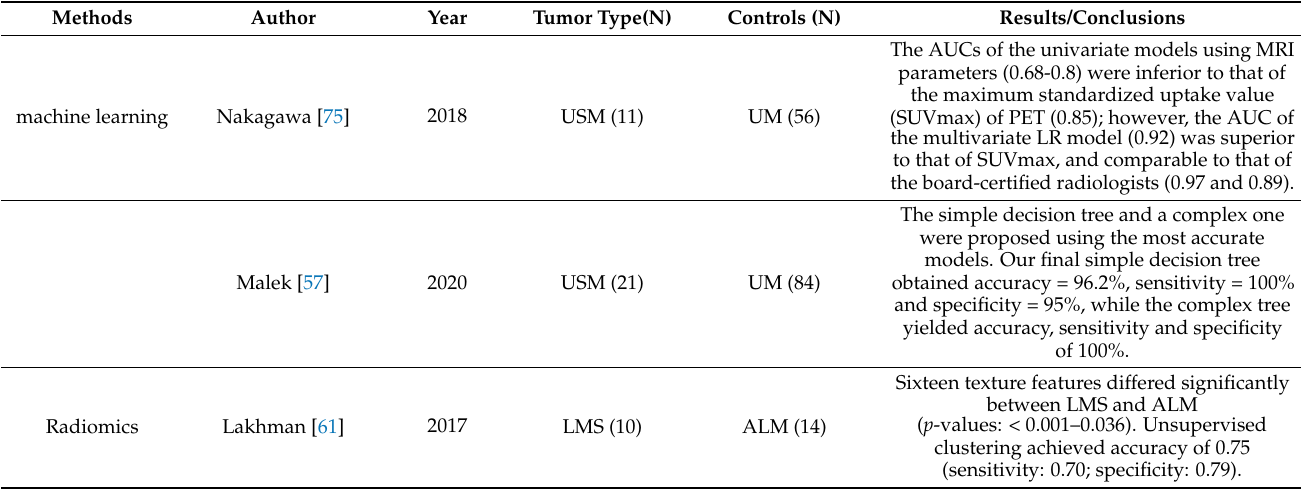
Table 3. Summary of machine learning, texture analysis, and radiomics